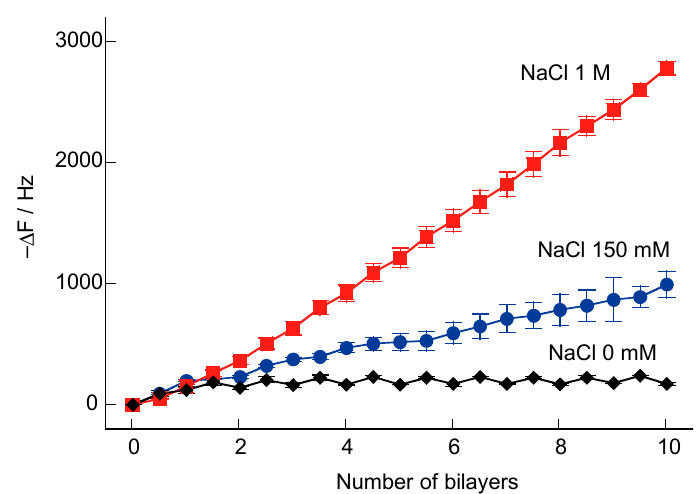
Figure 6. The effect of the pH value during the preparation of SA-PAH/PBA-PAH multilayer films in a 10 mM MES (pH 5.0), 10 mM HEPES (pH 7.4) or 10 mM CHES buffer (pH 9.0). All buffer solutions contained 150 mM NaCl. Polymers 2018 , 10 , x FOR PEER REVIEW